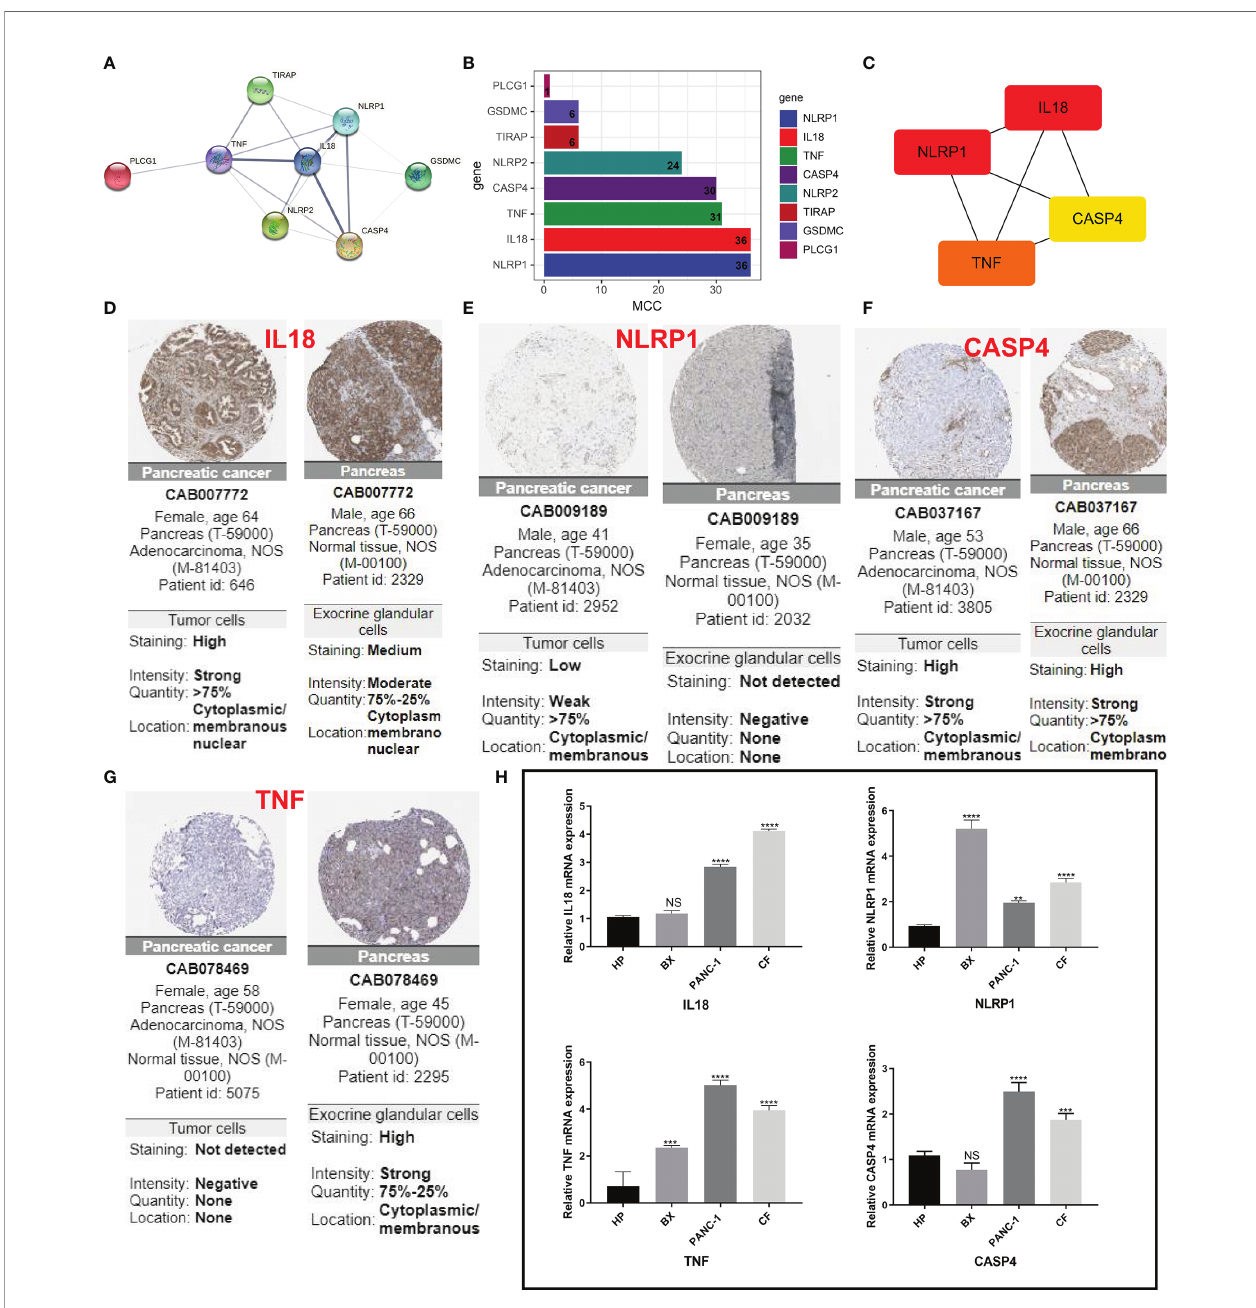
FIGURE 6 | IHC and immunohistochemical veri fi cation. (A) PPI network showing the cross talks of eight pyroptosis-related genes. (B, C) The MCC algorithm is used to calculate the expression score of these eight genes in pancreatic cancer and links between the four genes with higher expression scores. (D – G) HPA data resource was also used to explore the expression of these four markers in pancreatic cancer tissue samples and normal tissues. (H) The mRNA levels from different cells as determined by real-time PCR analysis. **P < 0.01; ***P < 0.001; **** < 0.0001. NS means not signi fi